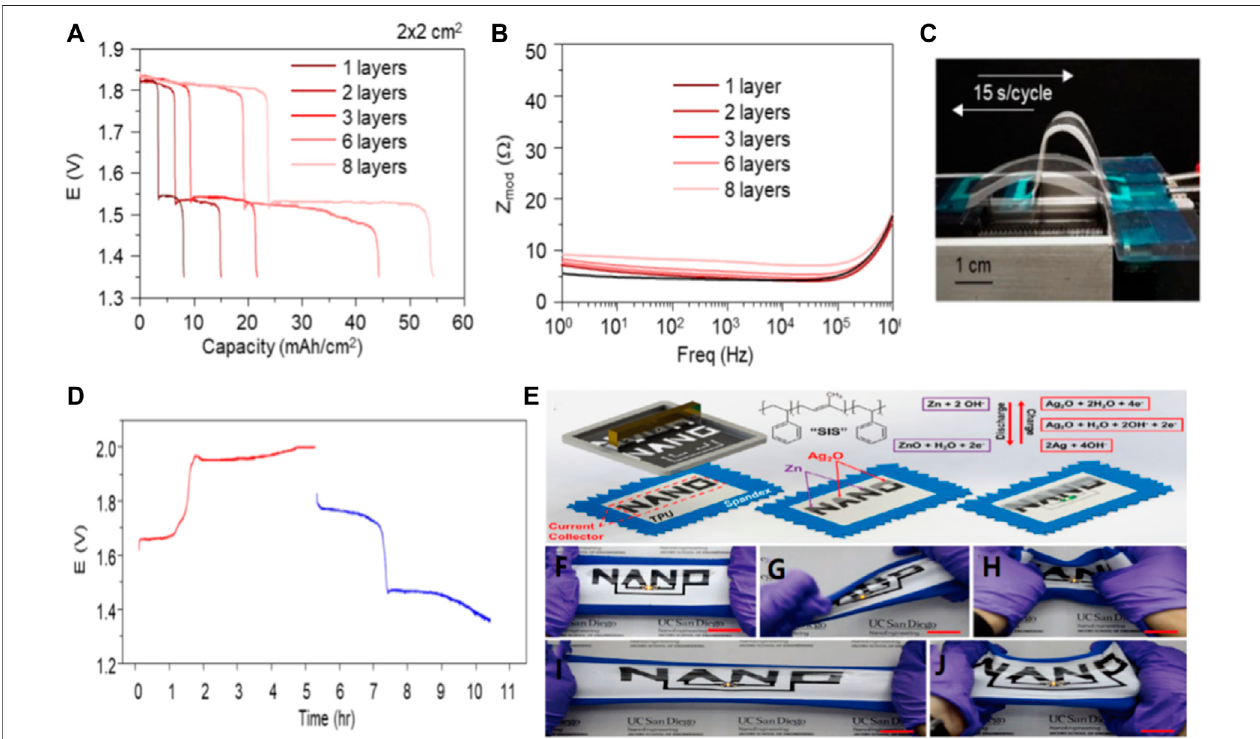
FIGURE3|(A) Electrochemical performanceofAgO-Zn batteriesasgalvanic cells. Theactive materialload isthecapacity ofthe 2×2 cm 2 batterywith1-8layers. (B) Bode plot re fl ecting the corresponding impedance of the 2 × 2 cm 2 cells with different areal loading. (C) Diagram of a cell controlled by a linear stage at a speed of 15 s/cycleunderrepeated180 ° bendingcycles,and (D) correspondingvolt-timecurvesforcharging (red)anddischarging(blue)ofthecellduringapproximately ~2,500 repeated bending cycles. Copyright 2020 ResearchGate. (E) Screen printing steps for Zn-Ag 2 O cells on stretchable fabric using SIS adhesive. Illustration: REDOX charging-discharging reaction. Photographs of the sealed cell during (F) horizontal stretching, (G) distortion, (H) indentation strain, (I) 100% stretching and (J) biaxial stretching. Copyright 2016 Advanced Energy